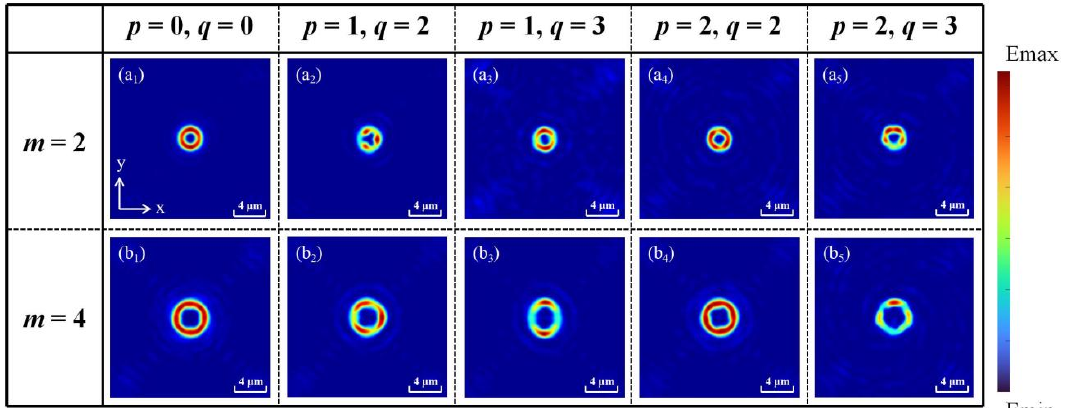
Figure 8. Polygonal beams generated by HOCP with different values of p and q when TCs are ( a ) m = 2 and ( b ) m = 4. ( a 1 , b 1 ) correspond to ordinary vortex beams. ( a 2 , b 2 ) correspond to the 3rd HOCP. ( a 3 , b 3 ) correspond to the special 4th HOCP. ( a 4 , b 4 ) correspond to the 4th HOCP. ( a 5 , b 5 ) correspond to the 5th HOCP.